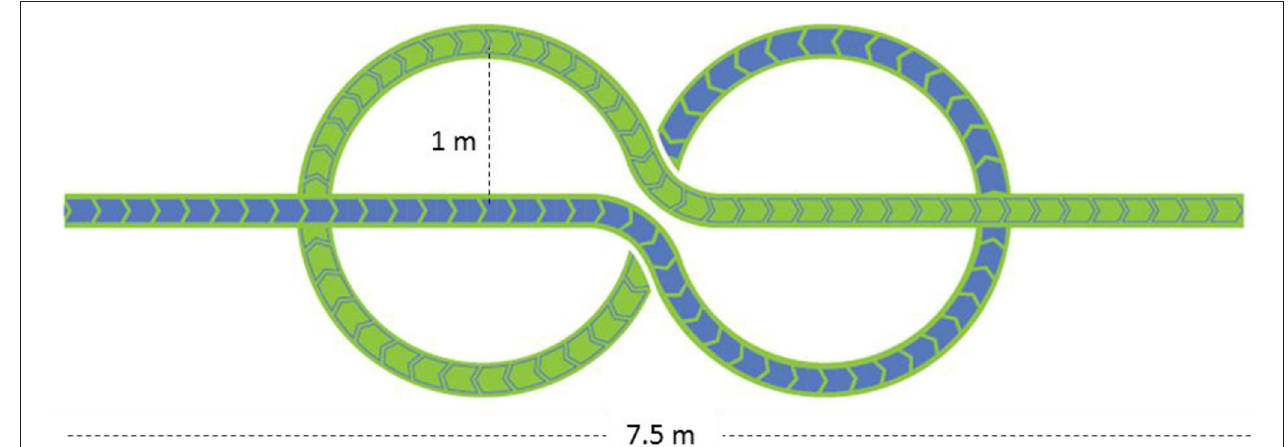
FIGURE 1 | The novel Figure-of-eight (nFo8) path. The path, printed on a large plastic carpet, is composed of a linear walking section (3.7m) followed by two curvilinear sections (each with a radius of 1m) and by a second linear